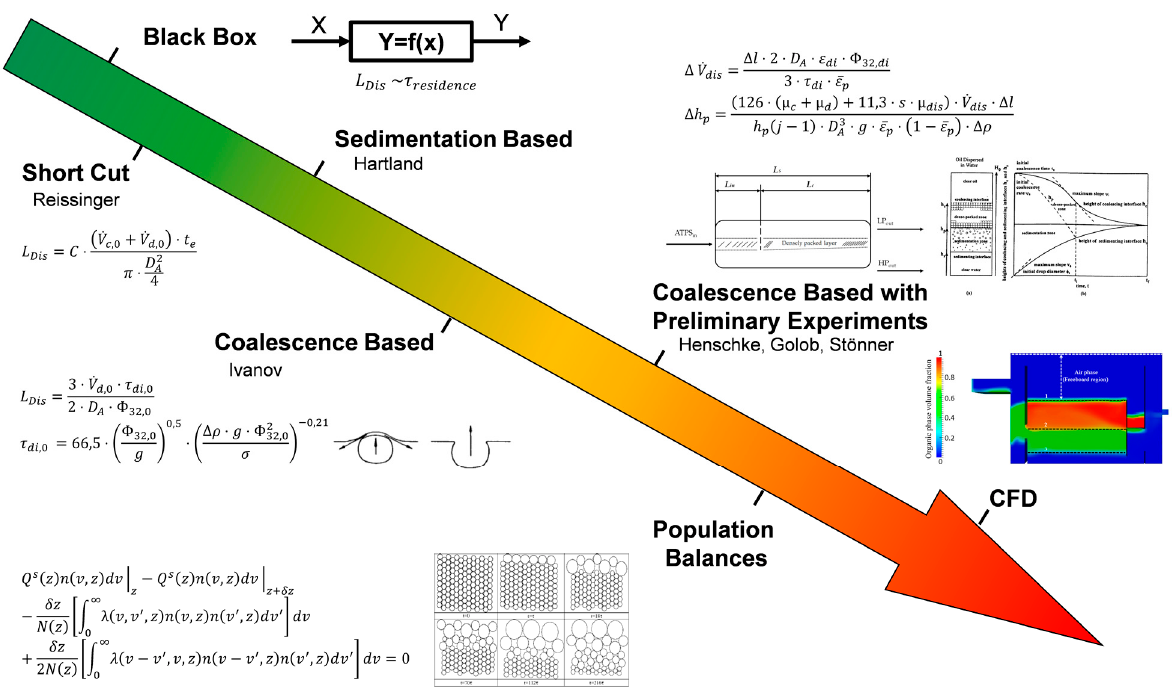
Figure 6. Schematic representation of increasing model depth with examples [26,30,32–37].